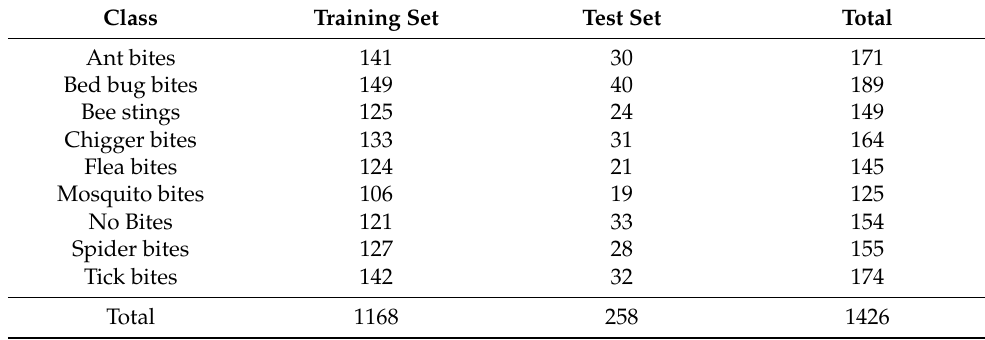
Table 1. Number of images per class in the final dataset for bug bites